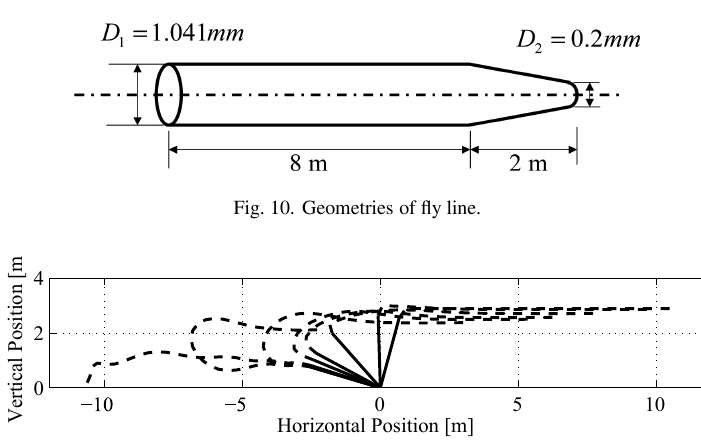
Fig. 11. Fly rod/line time history during a cast, where t = [0,0.1,0.15,0.18,0.2,0.25,0.35,0.5] s, and rigid rod butt at origin, [Rigid Rod Case].